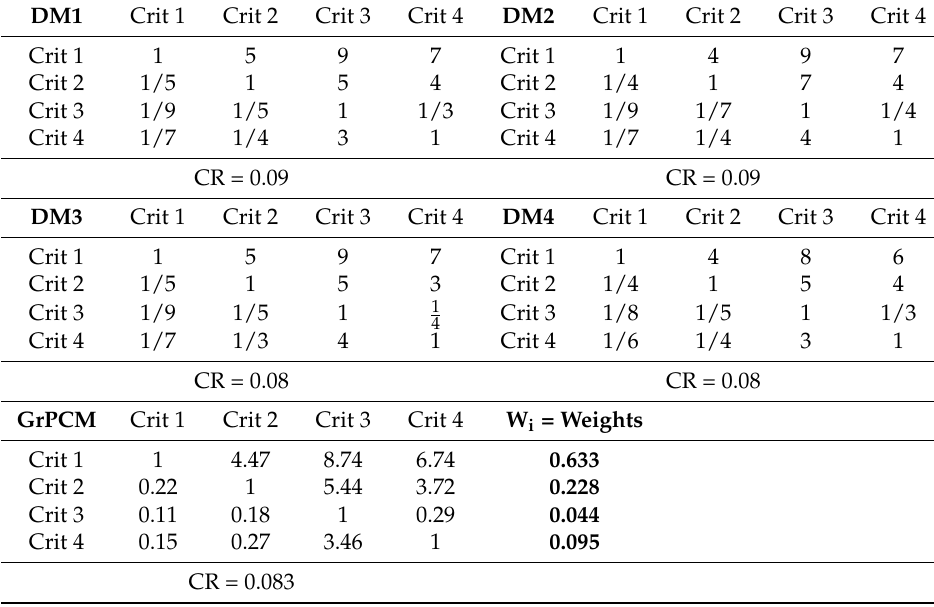
Table 3. Pairwise Comparison Matrices